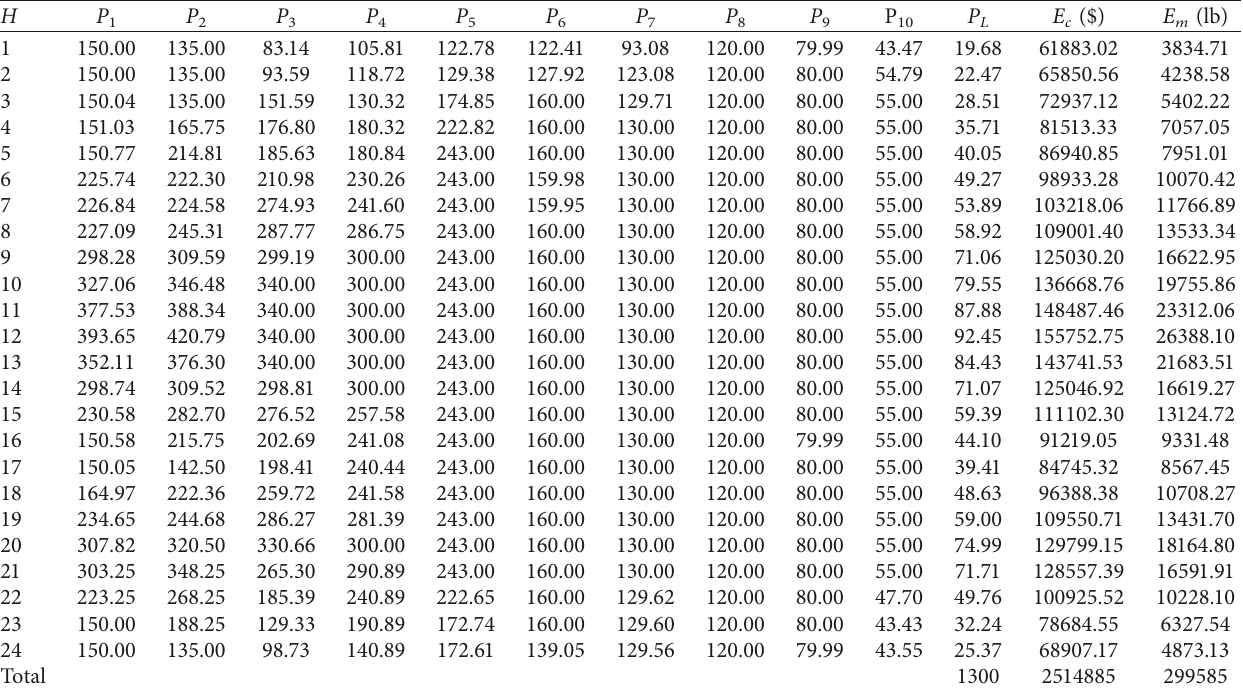
Table 8: Optimal compromise results for Case 2.